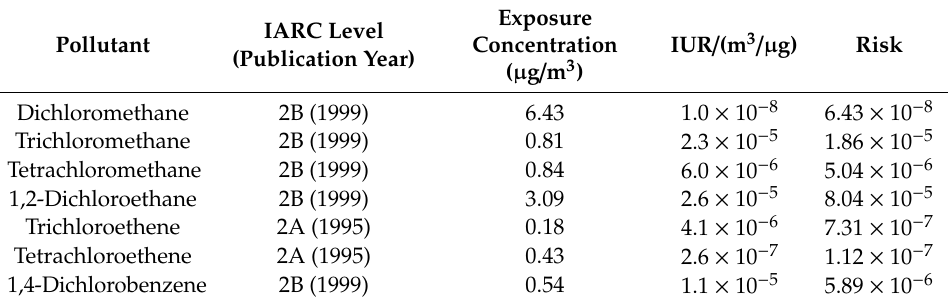
Table 3. Carcinogenic risk assessment for 7 volatile halogenated hydrocarbons.